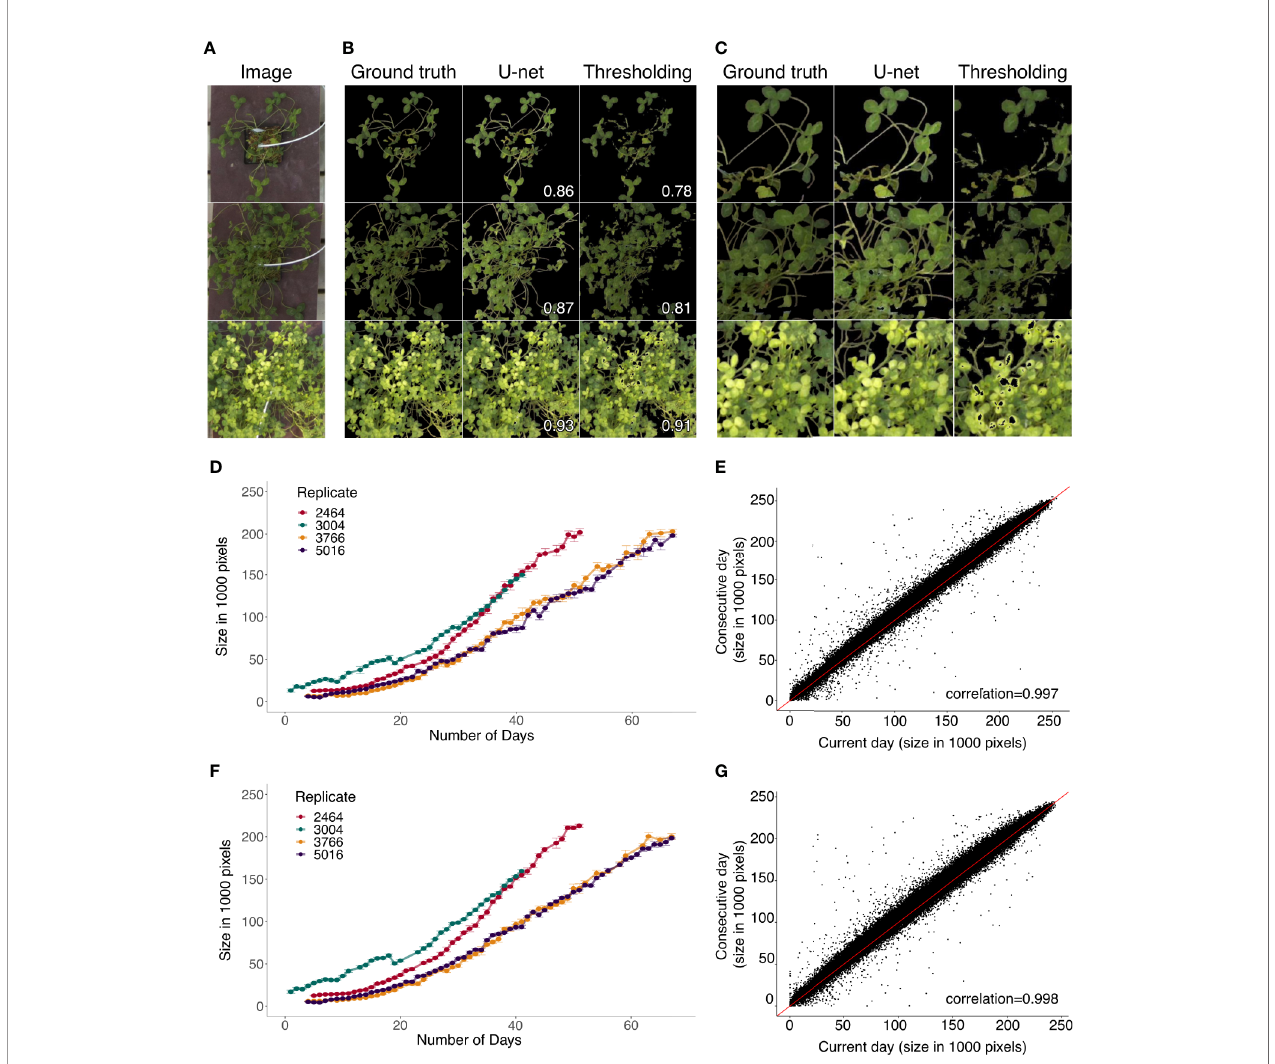
FIGURE 4 | (A) Three example images from the test set for segmentation. (B) Masks produced to the corresponding examples from (A) , showing the ground truth mask and the predictions from U-net and thresholding. Corresponding Jaccard index (intersection over union) statistics between the ground truth and predicted masks are displayed. (C) Zoomed in examples on the masks showing regions in which the U-net improved the prediction compared to thresholding. (D, F) Growth curve examples from the same replicates from the two different rounds, with replicates 2,464 and 3,004 from round 1 and replicates 3,766 and 5,016 from round 2. Growth curves made using thresholding (D) and U-net (F) . The units are the size of the plant area measured in the number of pixels from the predicted masks. (E, G) Change in plant size from the current day to the consecutive day across all days and plants using thresholding (E) and using U-net (G) . The red line corresponds to a 1:1 relationship. Pearson correlations are shown on bottom right corners (E, G)